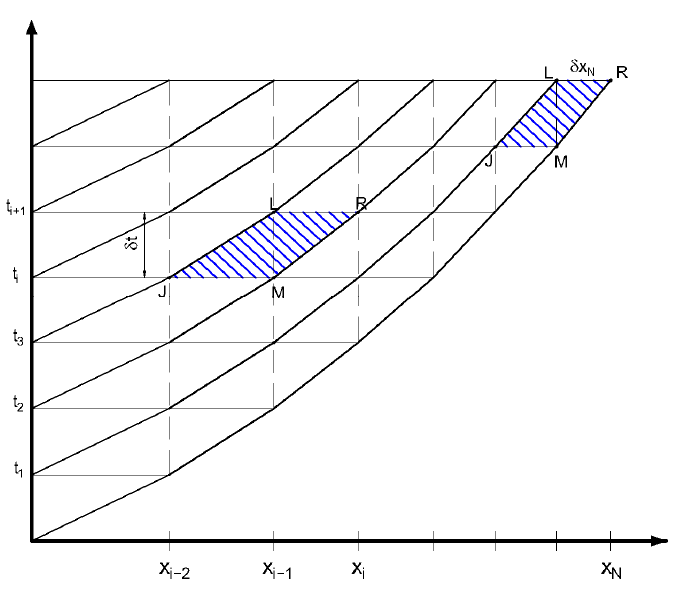
Figure 3. Computational grid for the advance phase.